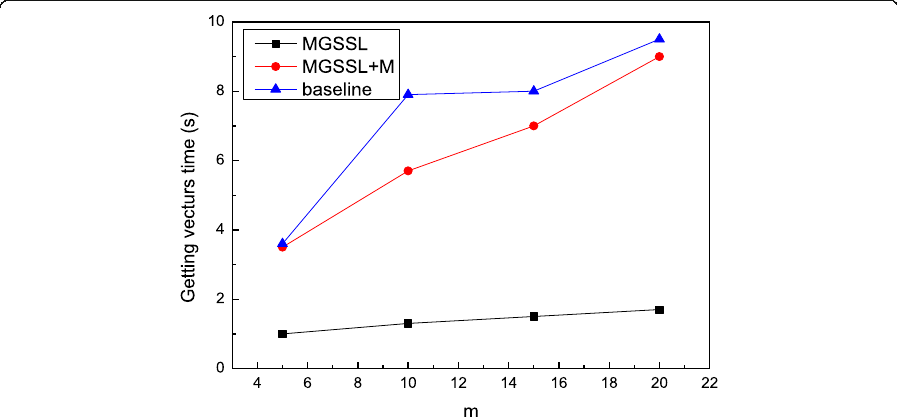
Fig. 4 Vectorization times of the optimal feature subset on 40 multi-dataset with label of MR - MGSSL , MGSSL+M , and